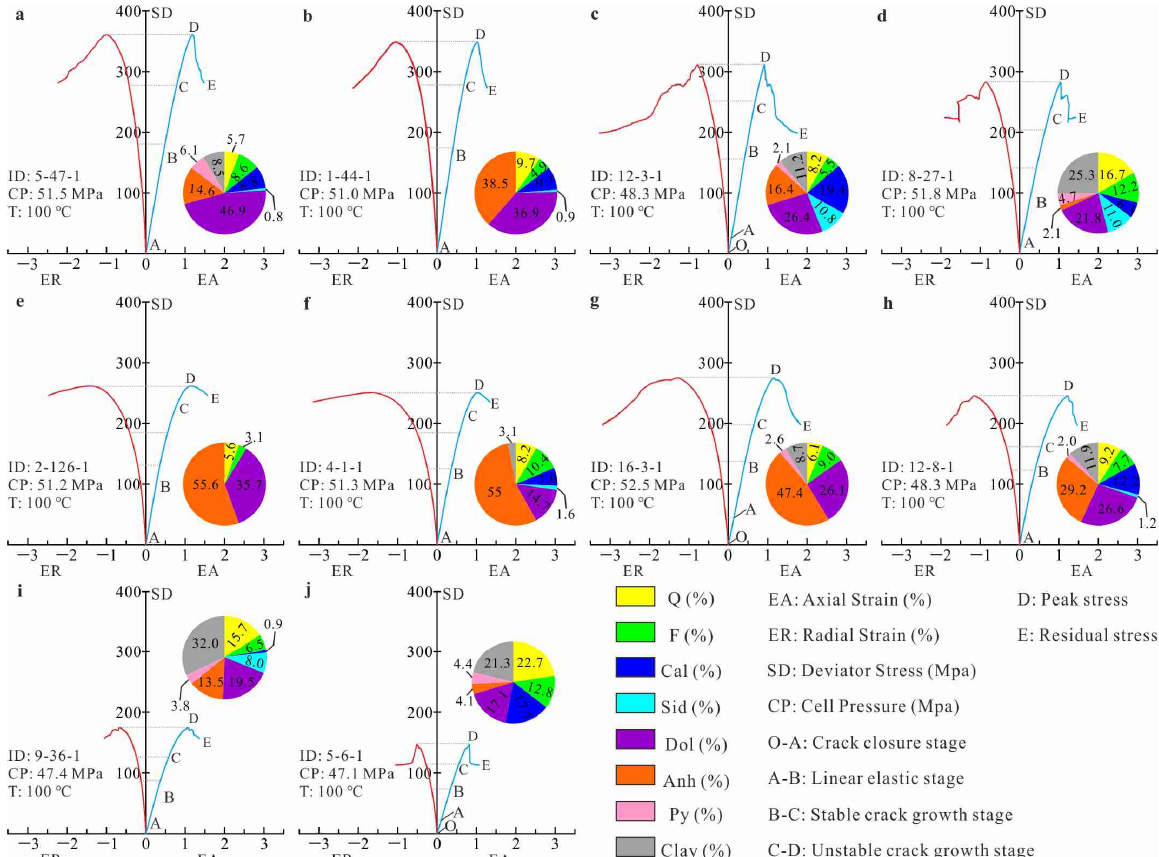
Figure 3. Diagrams of deviator stress–strain curves and the corresponding thresholds of different reservoir rocks (implications of corresponding thresholds after Zhou et al. (2018) [55] and Xiong et al. (2019) [56]). The pie charts are the results of X-ray diffraction of corresponding samples. ( a ) 5-47-1; ( b ) 1-44-1; ( c ) 12-3-1; ( d ) 8-27-1; ( e ) 2-126-1; ( f ) 4-1-1; ( g ) 16-3-1; ( h ) 12-8-1; ( i ) 9-36-1; ( j ) 5-6-1.